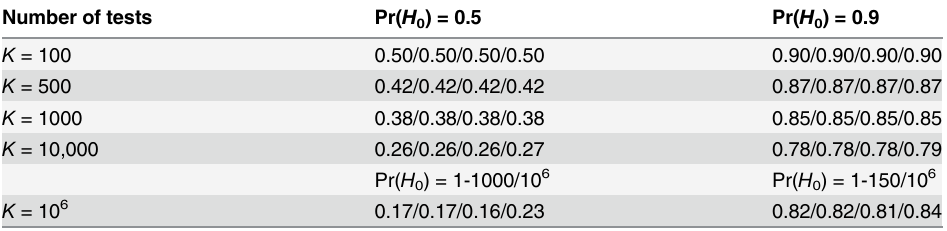
Table 2. The average of posterior probabilities among the 100 smallest P-values, i.e., the false discov- ery rate (FDR) among the 100 smallest P-values. Table entries W/X/Y/Z give the true averaged probability (W), followed by the estimated averaged probabilities using the integration method (X); the discretization method (Y); the distribution mean method (Z). Sample sizes ( n 1 , n 2 : number of cases, controls in allele counts): n 1 + n 2 = 800 for K = 10 to 10,000; n 1 + n 2 = 14000 for K = 10 6 .